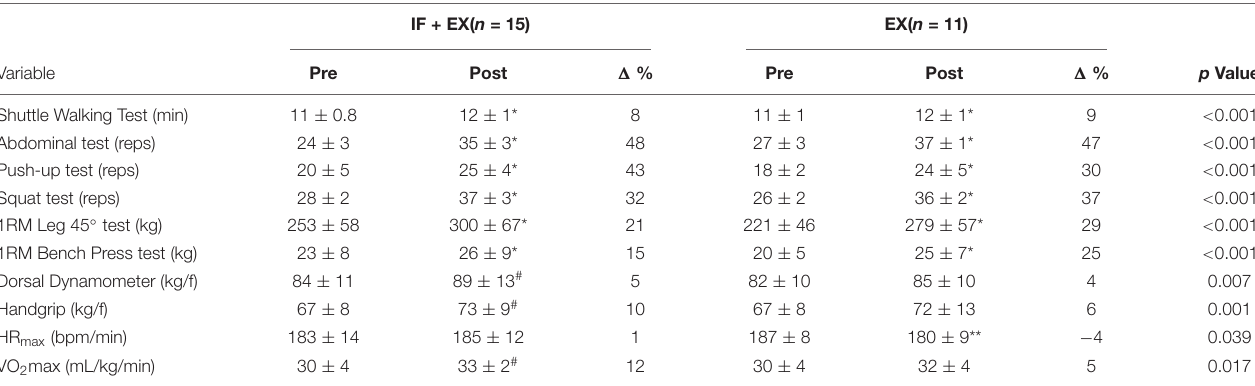
TABLE 4 | Physical fitness (aerobic and muscle strength) pre and post